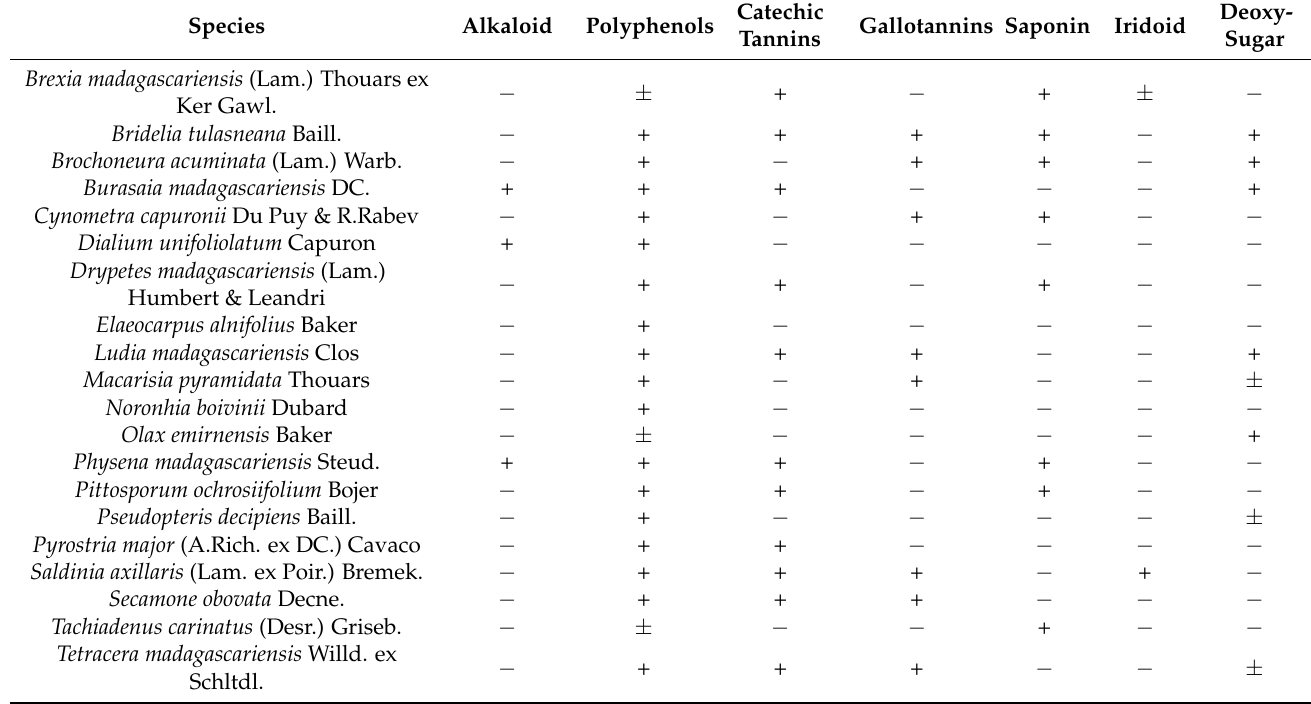
Catechic Gallotannins Saponin Iridoid Tannins